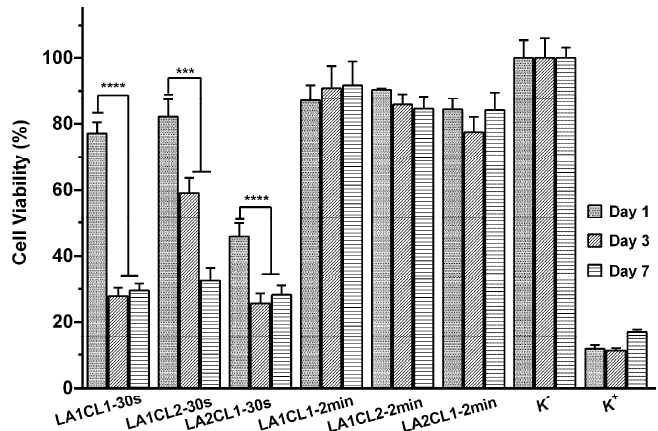
Figure 8. Characterization of cell viability through the MTT assay after 1, 3 and 7 days of incubation. K − (negative control); K + (positive control). Data are presented as the mean ± standard deviation, n = 5, *** p < 0.001, **** p < 0.0001.